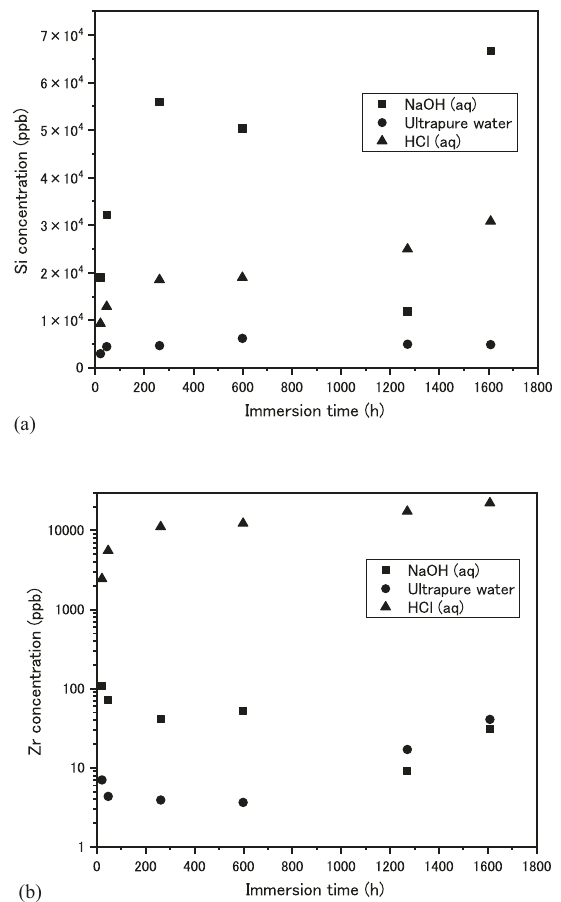
Fig. 2 The elemental concentration changes in 0.1 M NaOH (aq), ultrapure water, and 0.1 M HCl (aq). a The concentrations of Si in 0.1 M NaOH (aq), ultrapure water, and 0.1 M HCl (aq). b The concentrations of Zr in 0.1 M NaOH (aq), ultrapure water, and 0.1 M HCl (aq).